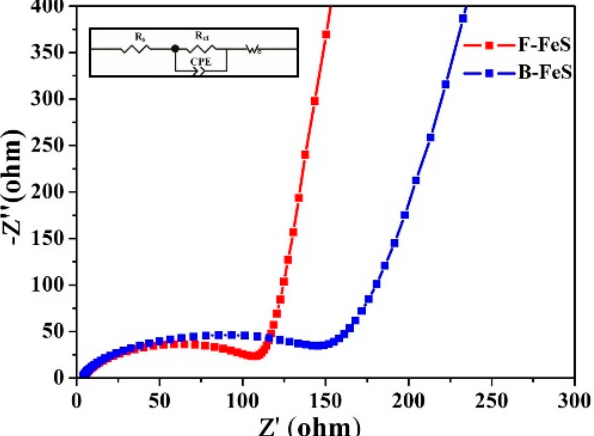
Figure 7. Electrochemical impedance spectra and equivalent circuit of 3D F-FeS and B-FeS nanostructures electrodes before cycling. A sine wave with amplitude of 10.0 mV over the frequency range from 100 kHz to 10 mHz.